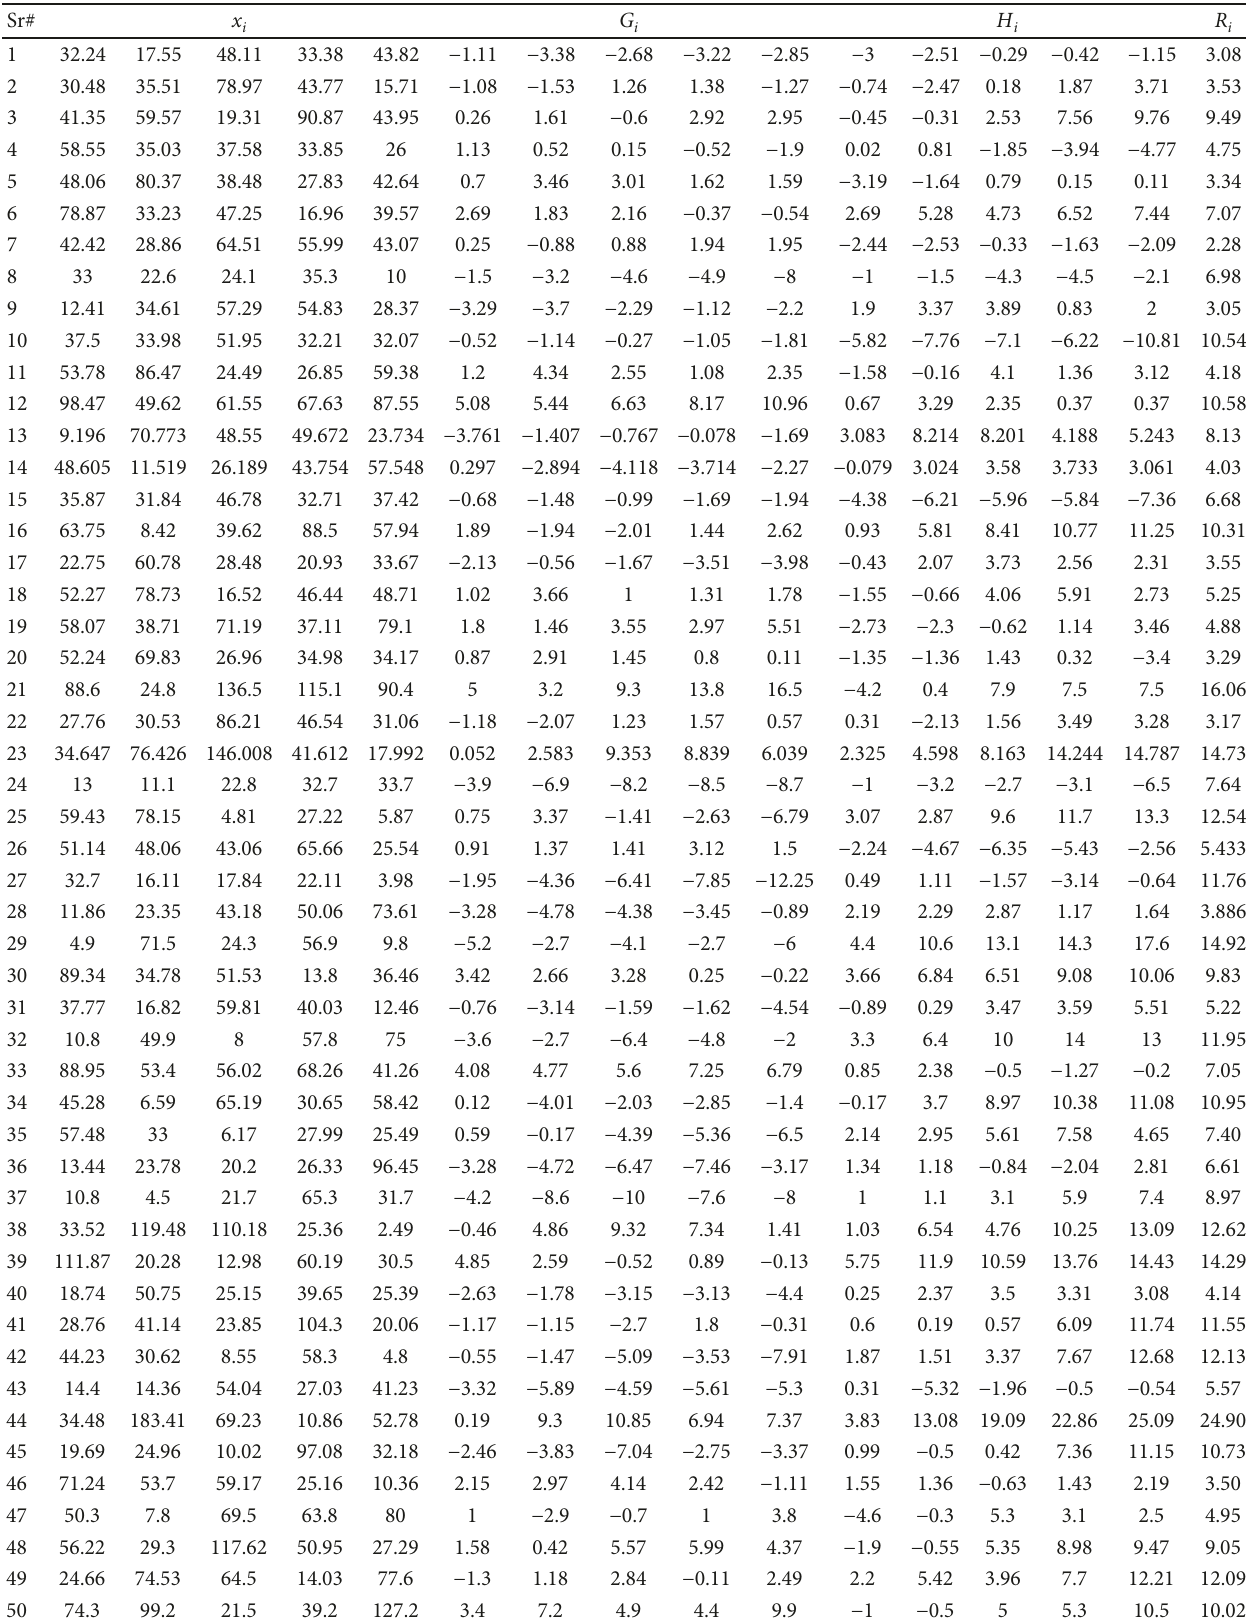
Table 6: The simulation data when α = 1 10 and β = 2 0